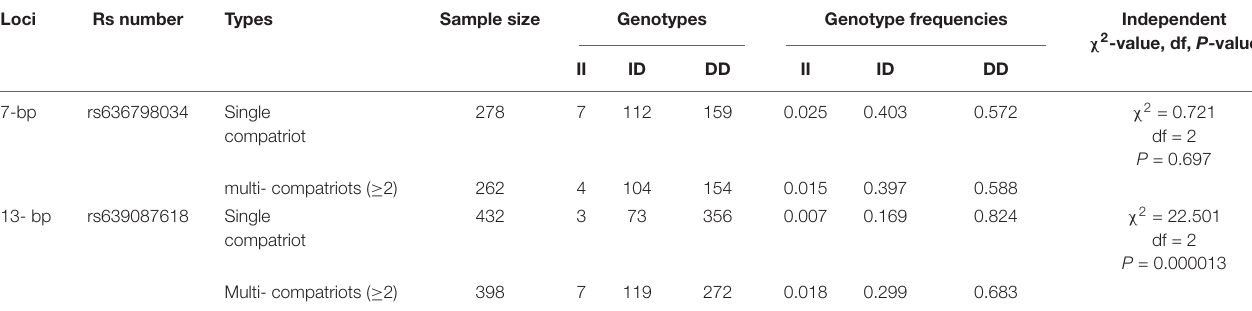
TABLE 4 | Genotype distribution between goats with single- and multi-lamb in Shaanbei white cashmere (SBWC) goats. Loci